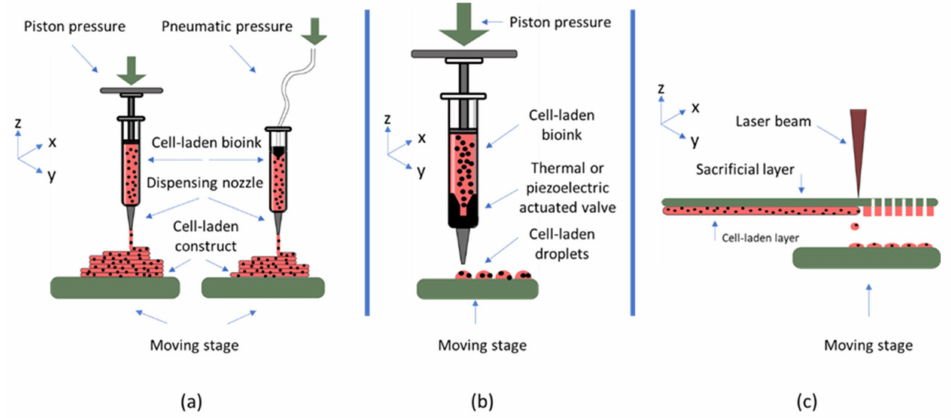
Figure 2. Most widespread bioprinting technologies are ( a ) extrusion-based bioprinting ( b ) inkjet bioprinting, and ( c ) laser-based